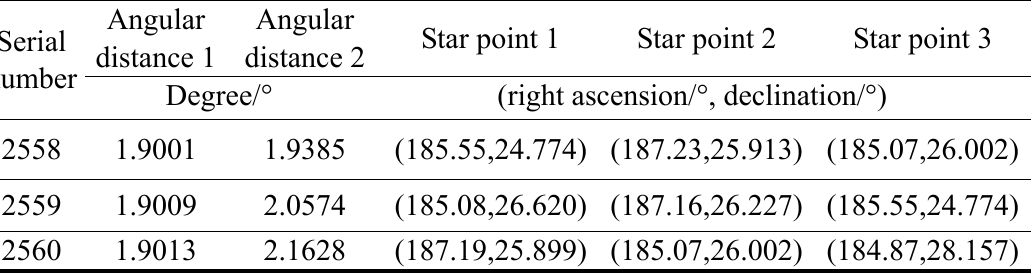
Table 1. Part of data stored in the Guidance-star